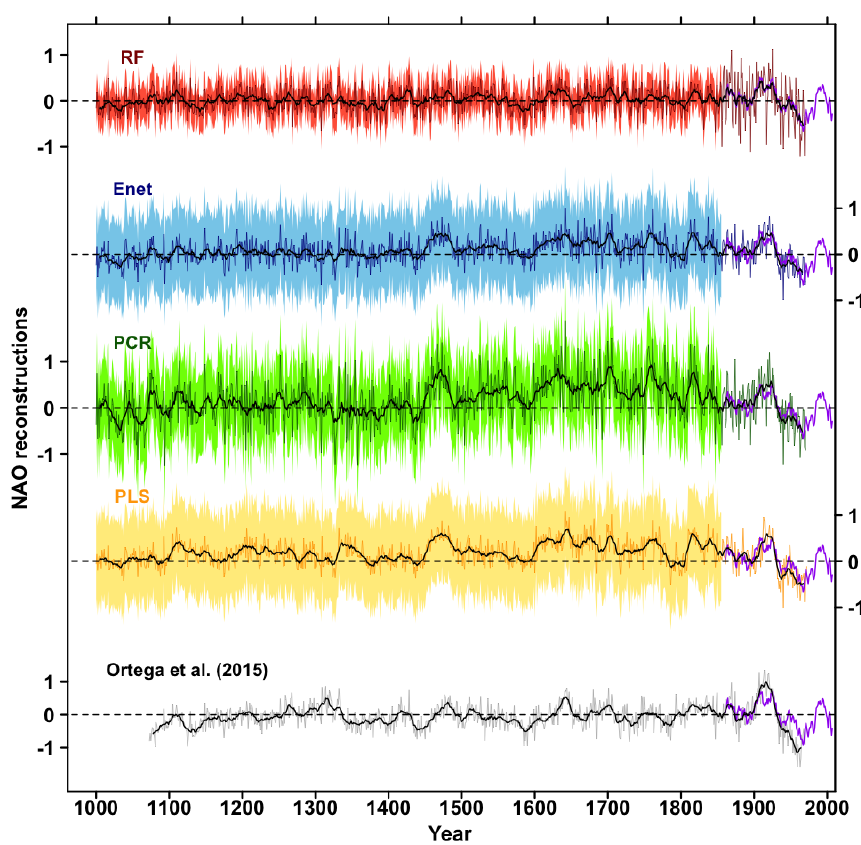
Figure 7. Red line: RF reconstruction for the period 1000–1972 (Sect. 3.1.2), using proxy records significantly correlated at the 80% confidence level with the NAO over the training periods (Sect. 3.1.1). Blue line: Enet reconstruction for the period 1000–1971 (Sect. 3.1.2) by selecting the proxy records significantly correlated with the NAO index at the 95% confidence level over the training periods (Sect. 3.1.1). Green line: PCR reconstruction for the period 1000–1971 (Sect. 3.1.2) by selecting the proxy records significantly correlated with the NAO index at the 95% confidence level over the training periods (Sect. 3.1.1). Orange line: PLS reconstruction for the period 1000–1972 (Sect. 3.1.2) by selecting the proxy records significantly correlated with the NAO index at the 95% confidence level over the training periods (Sect. 3.1.1). Thin black line: calibration-constrained reconstruction (Ortega et al., 2015). Red area: regression uncertainties (see Sect. S3) for the RF reconstruction. Blue area: regression uncertainties for the Enet reconstruction. Blue area: regression uncertainties for the PCR reconstruction. Orange area: regression uncertainties for the PLS reconstruction. Thick black lines are the corresponding 11-year filtered reconstructions for each method. Purple lines: superposed 11-year filtered NAO index from Jones et al.